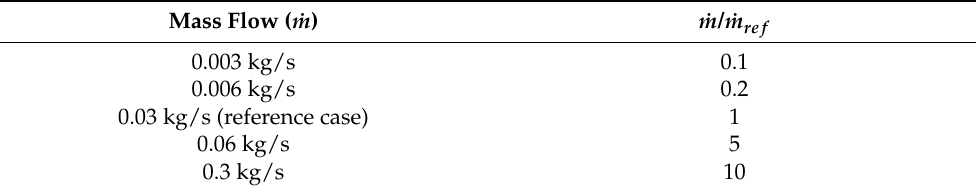
Table 8. Simulated mass